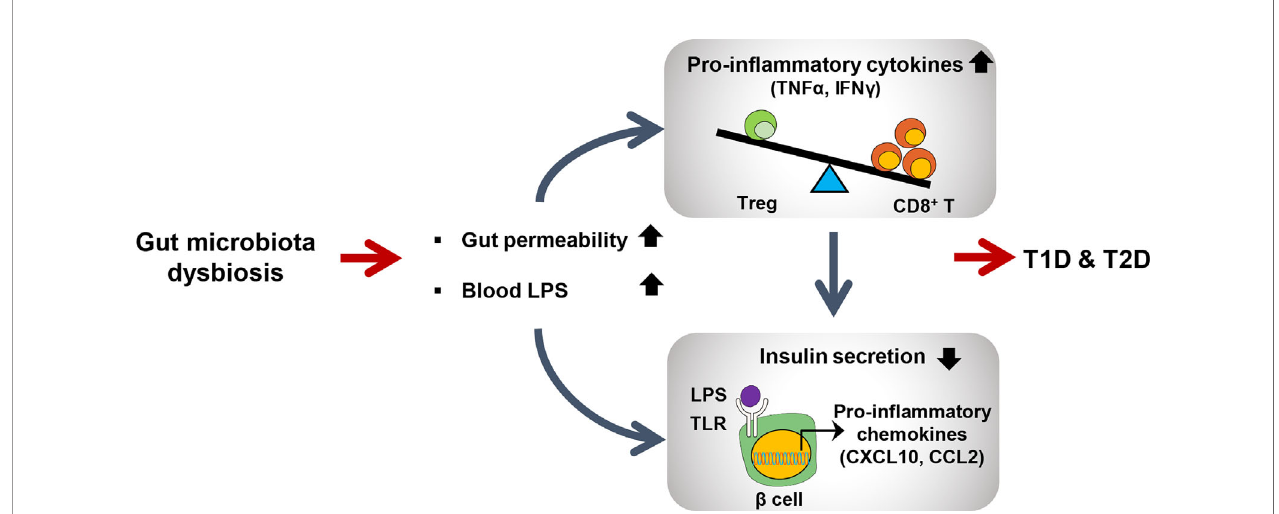
FIGURE 2 | Schematic view of gut microbiota dysbiosis contributing to both type 1 and type2 diabetes. Dysbiosis leads to increased intestinal permeability and LPS level in blood. Elevated LPS level activates CD8+ T cells to produce proin fl ammatory cytokines to further activate immune signaling pathways in many peripheral tissues including pancreatic beta cells. LPS-induced TLR signaling in pancreatic beta cells promotes in fl ammation to reduce insulin